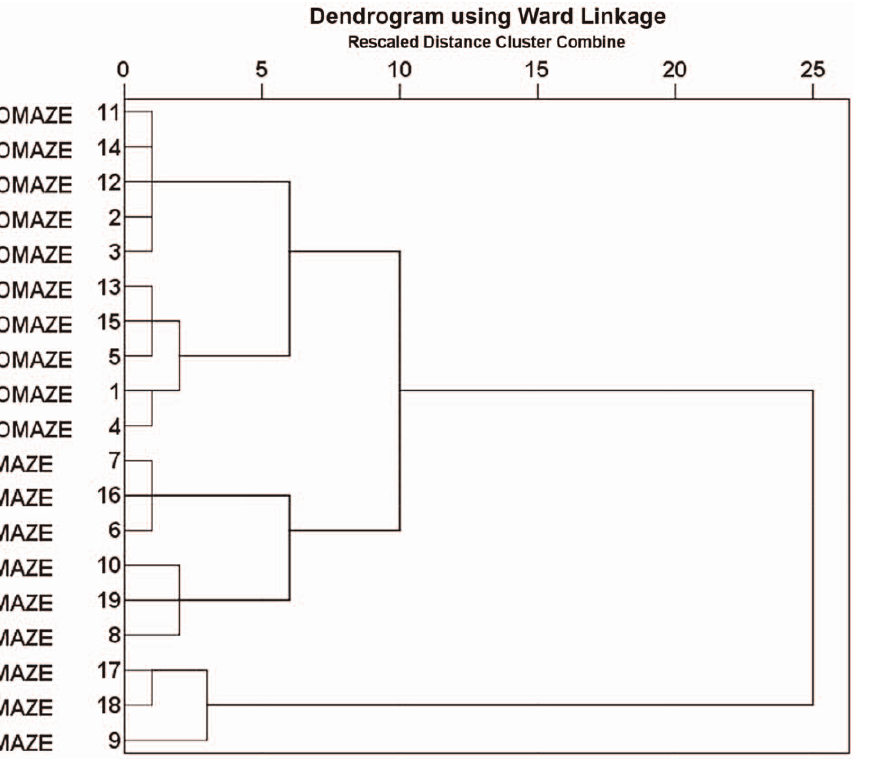
Figure 5. Cluster analysis, using the correlation coefficient distance and Ward’s minimal variance algorithm, on the neurochemical data at 6 months post-op. in CA2/3, showing individual animals according to training (T maze or no T maze). Note that the neurochemical data for CA2/3 can completely distinguish the trained from the non-trained animals.